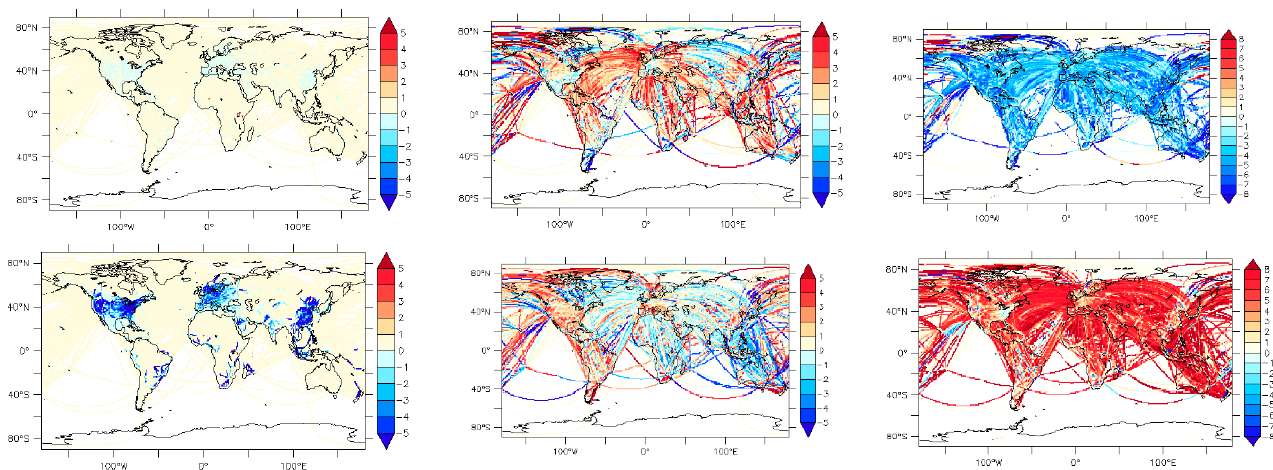
Figure A2. Relative differences of global distribution of aviation flight distance, nitrogen oxides and soot emissions [%]; difference between inventories Flying Higher ( upper ) and Flying Lower ( lower ) showing flight distance ( left ), nitrogen oxides ( middle ) and soot emissions.